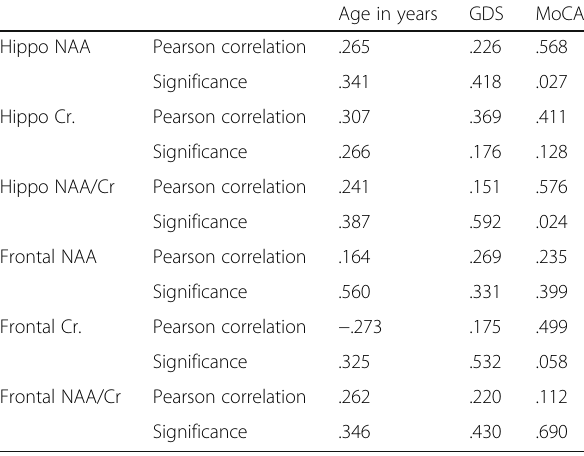
Table 2 Correlations between age, clinical, and spectroscopic data in patients with AD